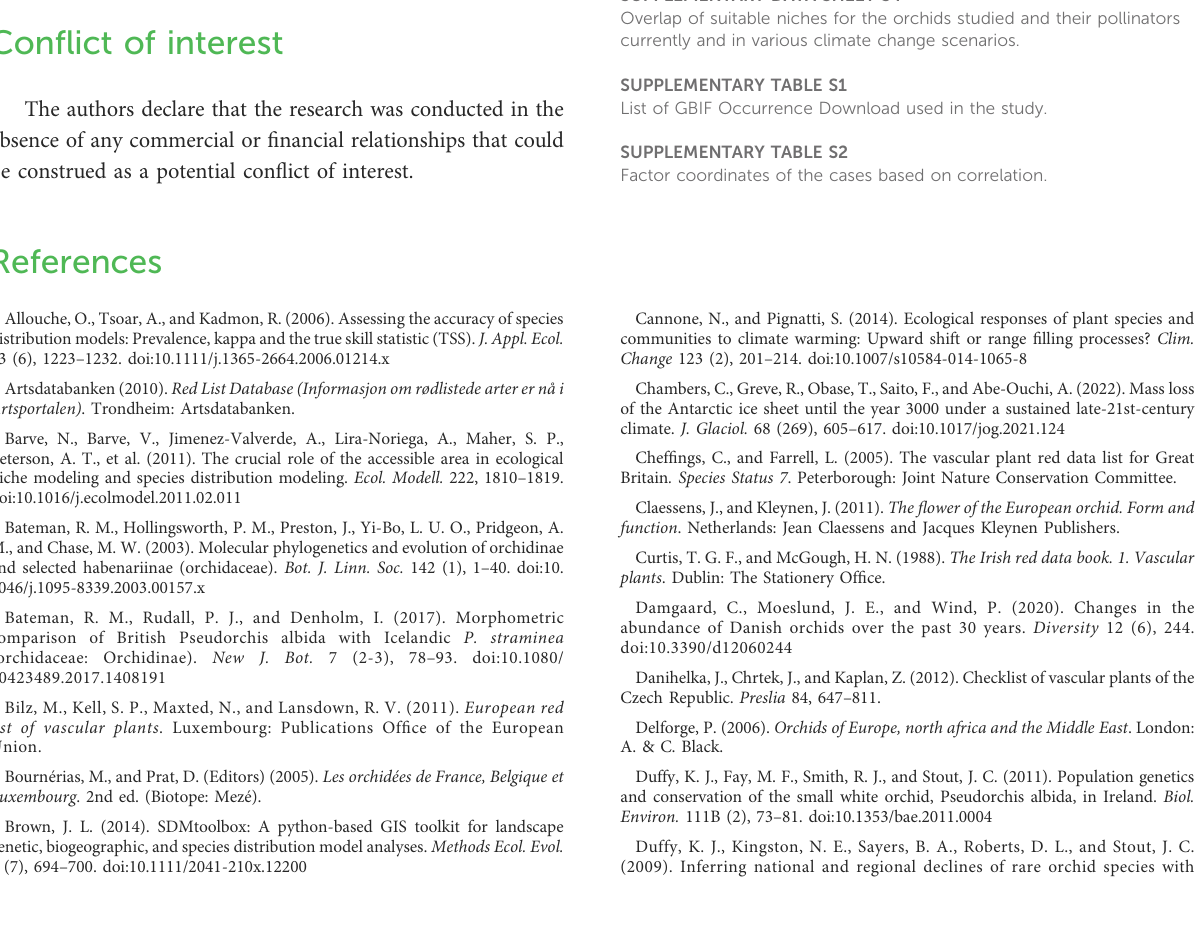
SUPPLEMENTARY TABLE S1 List of GBIF Occurrence Download used in the study. SUPPLEMENTARY TABLE S2 Factor coordinates of the cases based on